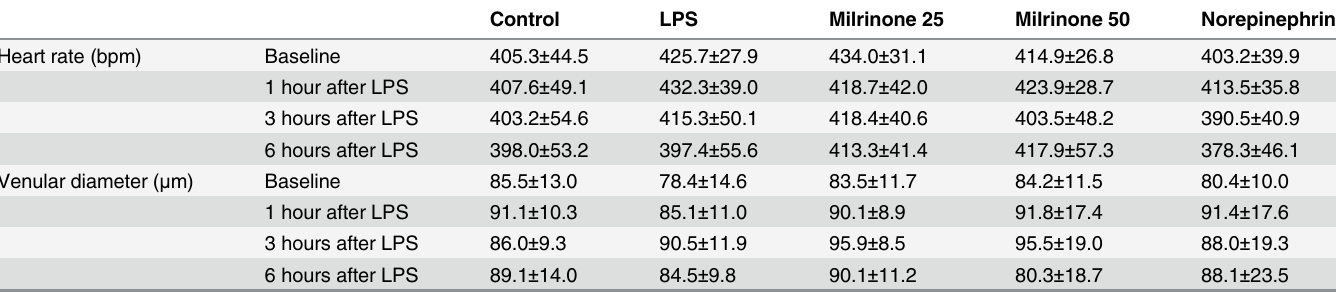
Table 1. Heart rate and venular mean internal diameter evolution during the experimental period.